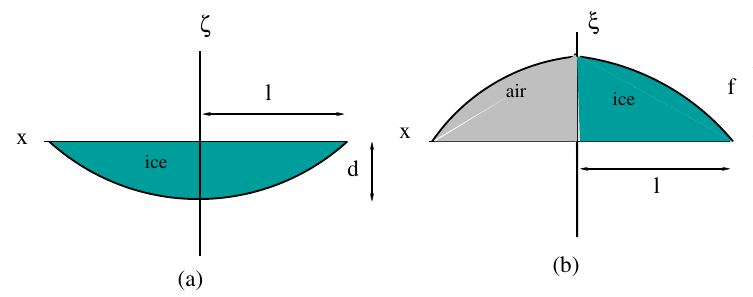
Figure 3: Shape of side (a) and basis (b)